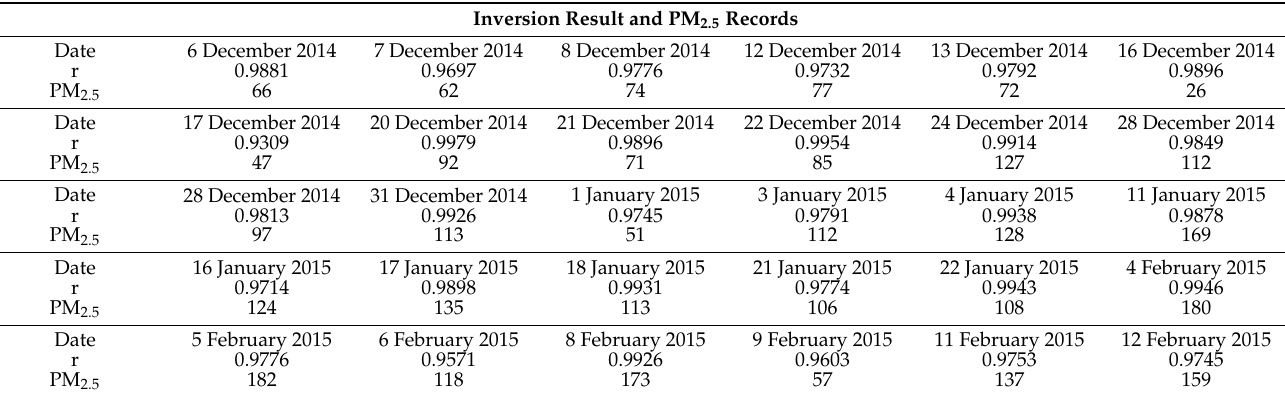
Table 2. Winter 30-day inversion results with PM 2.5